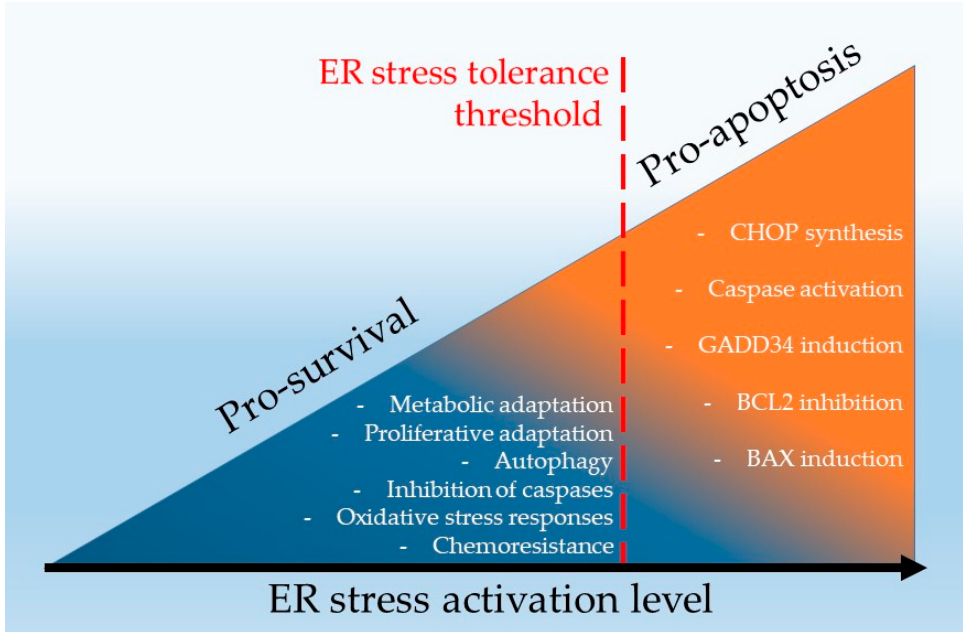
Figure 5. Dichotomous function of ER stress in renal cancer cells.